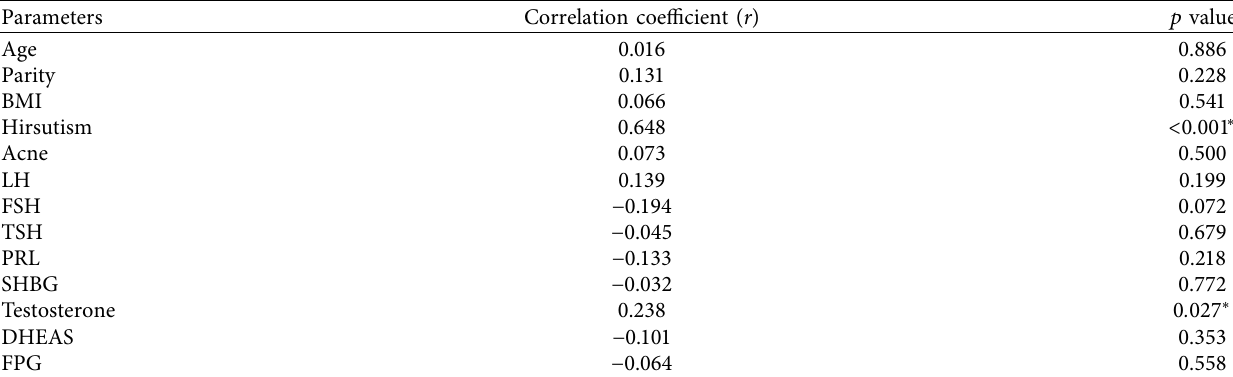
Table 2: Correlations between kisspeptin with demographic and clinical characteristics and hormonal and metabolic profiles of all subjects (including controls).